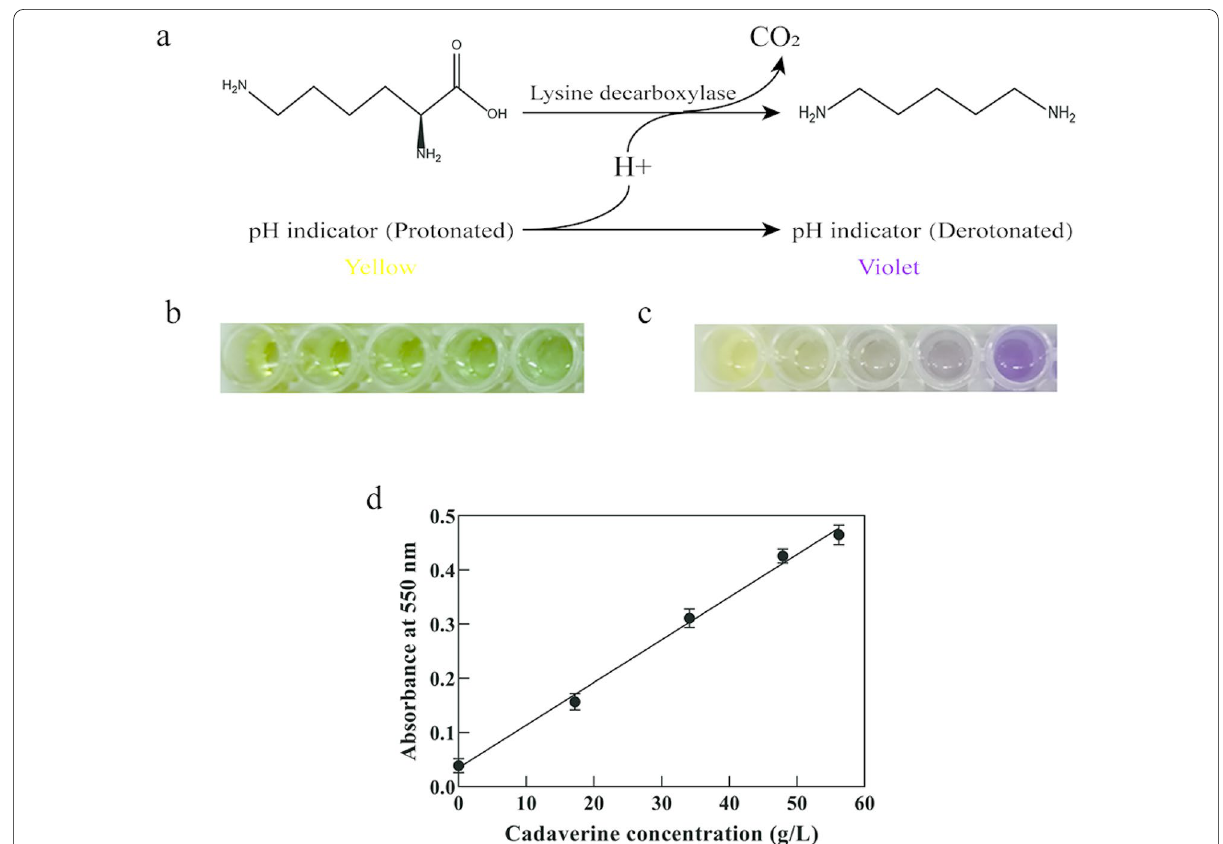
Fig. 1 Establishment of the HTS method. a Colorimetric method for the determination of lysine decarboxylase activity. b Color change of thymol blue with pH increase at pH 8.0. c Color change of the mixed indicator with pH increase at pH 8.0. d Correlation between the absorbance at 550 nm and the HPLC results. The reaction was conducted at 50 ºC in borate buffer (pH 8.0), and samples were taken after 0, 15, 30, 45, and 60 min of reaction. The cadaverine concentration was determined by HPLC. The error bars represent standard deviations calculated from triplicate experiments